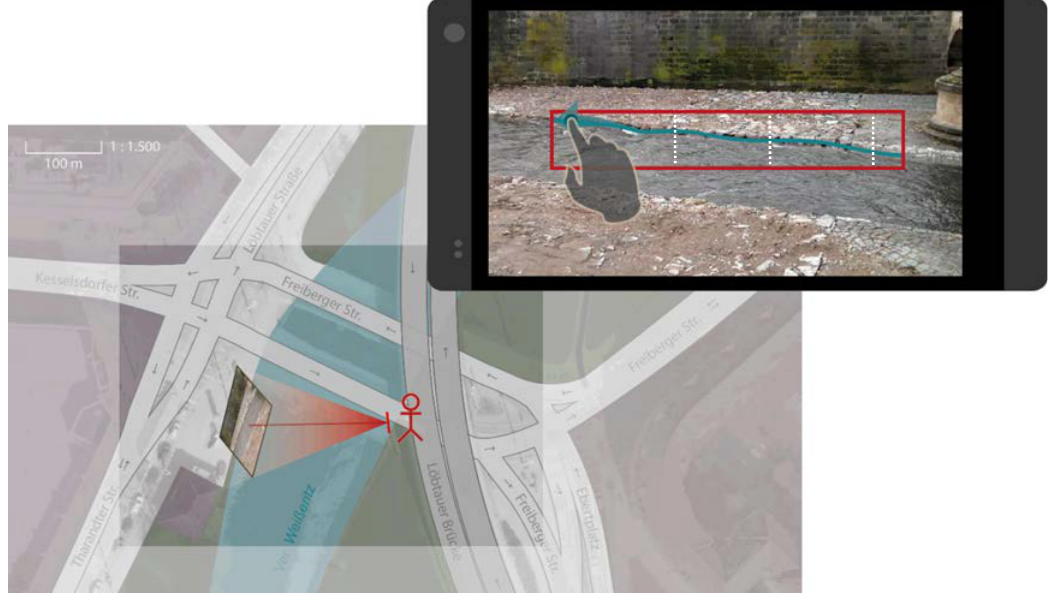
Figure 1: Study region of river Weißeritz and nearshore environment situated in Dresden (left); Scheme of data acquisition and detail view for exemplary selection of column-by-column image profiles